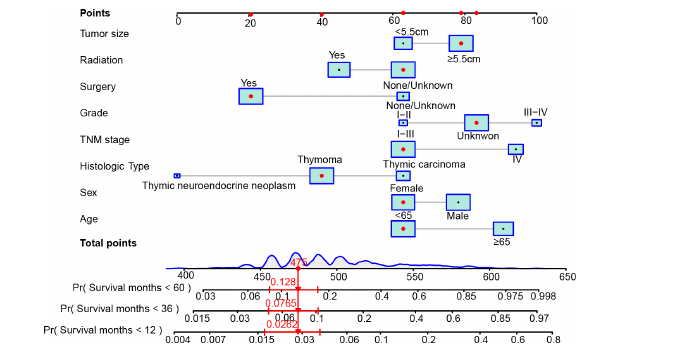
validation cohort. In our in-house cohort, the constructed nomogram only provided signi fi cant improvement of NRI and IDI in predicting the 12-month OS probability of patients with TETs (Table 3).